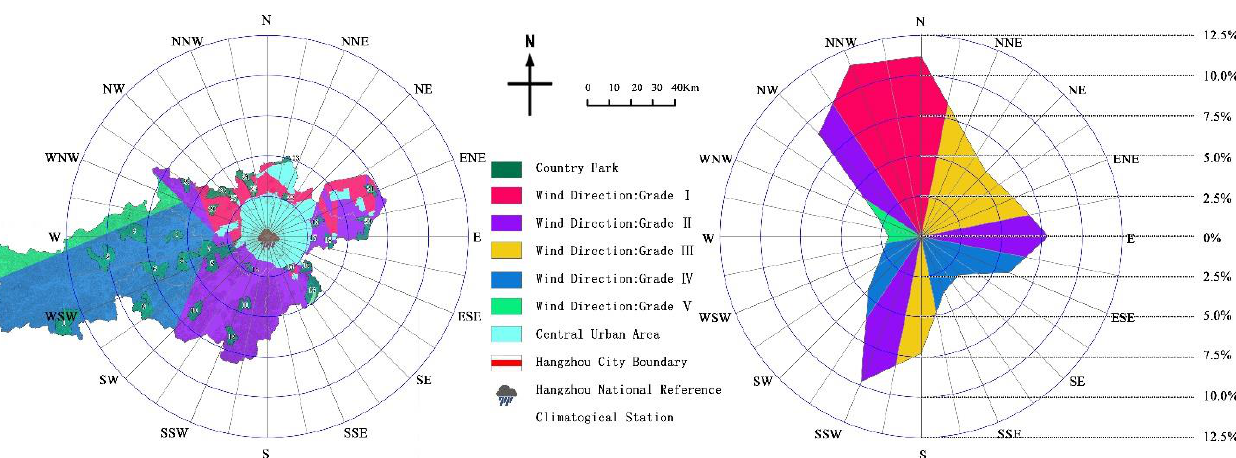
Table 13. The results of distance assignment of country parks from city center. Park Number Ⅲ Figure 9. The distance from city center of the country parks.